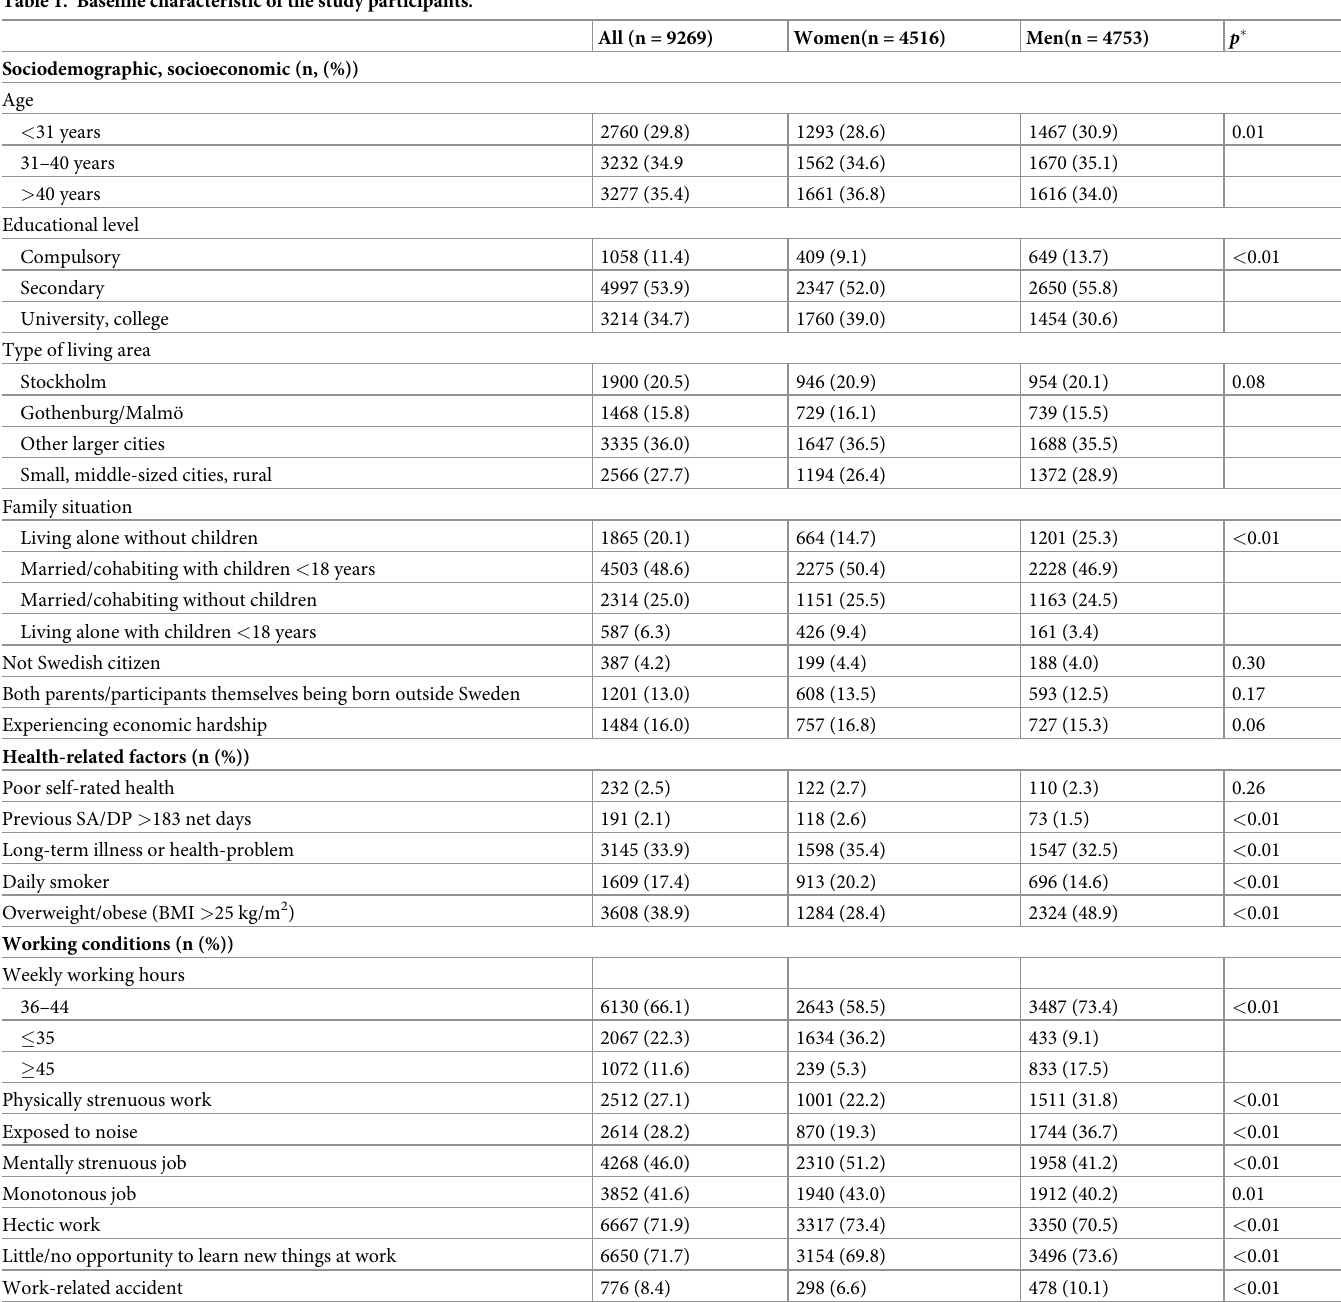
Table 1. Baseline characteristic of the study